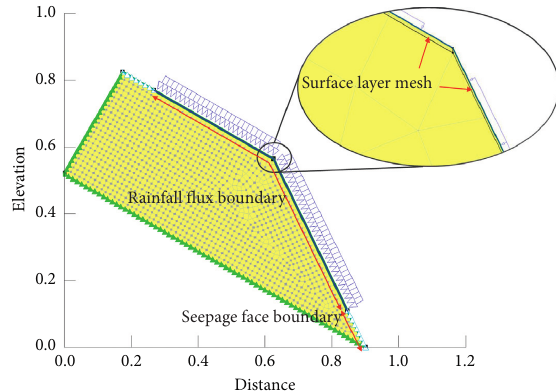
Figure 5: Domain and boundary conditions of seepage modeling and zoomed-in view of the surface layer